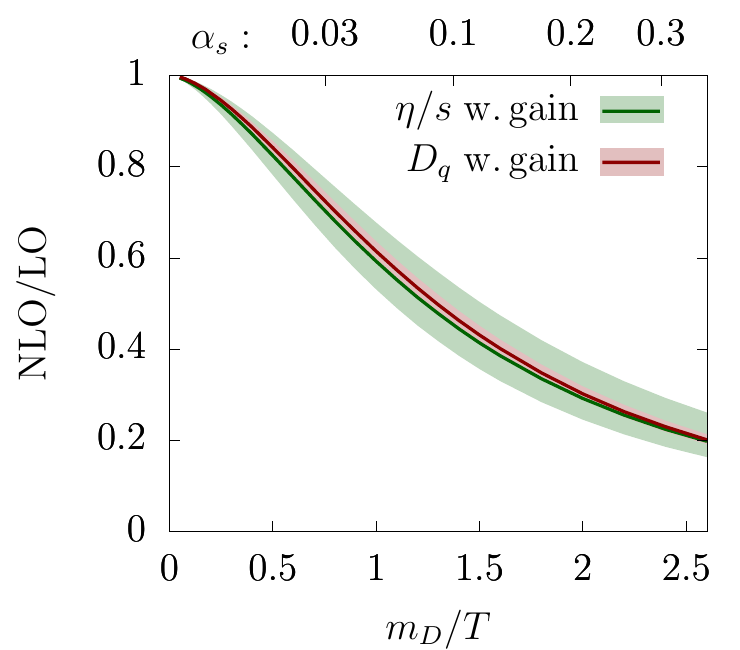
Figure 7 . The NLO/LO ratio for the shear viscosity and di(cid:11)usion constant for QCD with N f = 3. The uncertainty bands from the unknown gain terms are described in (cid:12)gure